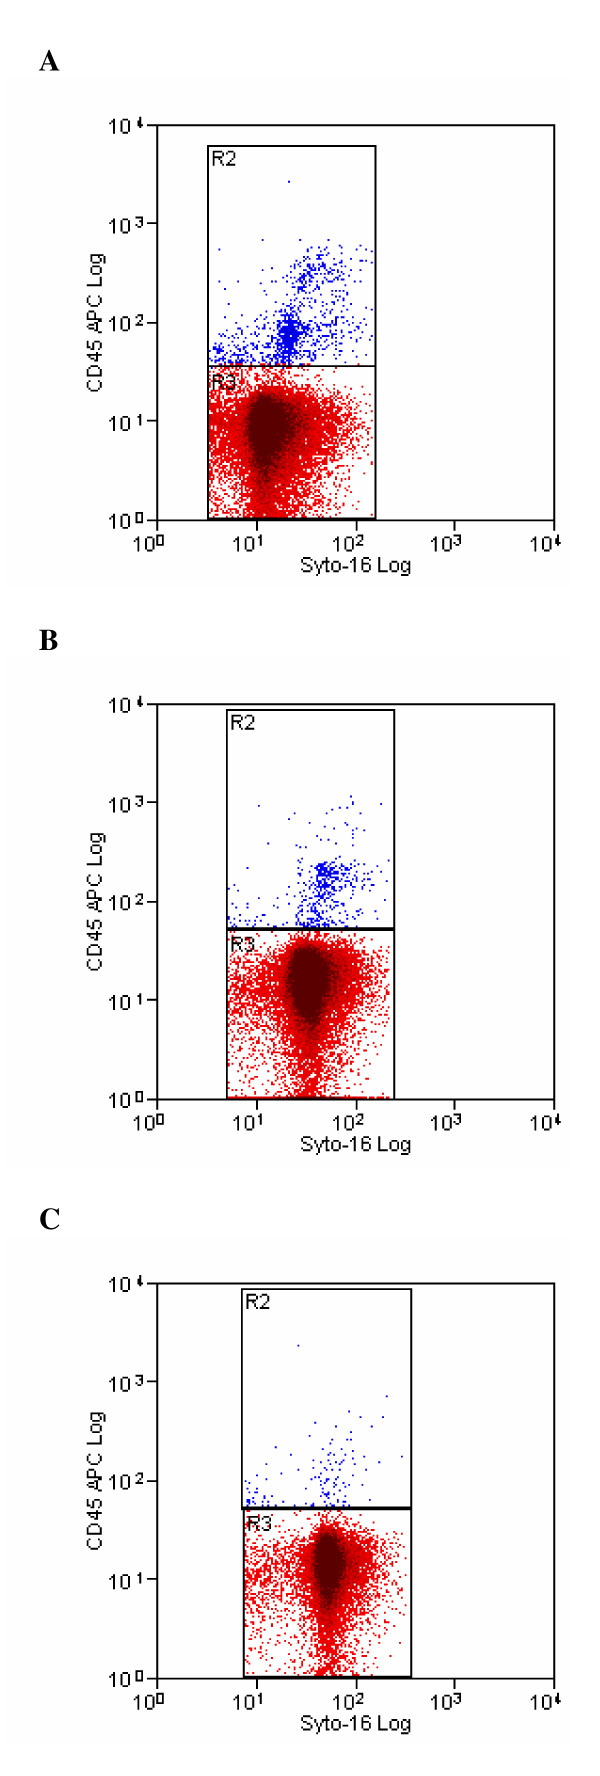
Pre- (3a) and post-processing (3b, 3c) cytofluorimetric analysis of a semen sample with a moderate leukocyte concentration. Cytogram 3a displays the cytofluorimetric analysis of a semen sample containing a moderate concentration of leukocytes moderate, stained with Syto-16 and CD45 to identify sperm and leukocytes. Region R2 (blue colour) and Region 3 (red colour) represent the number of leukocytes and sperm counted, respectively. Cytograms 3b and 3c displays the cytofluorimetric analysis of the same sample after density-gradient centrifugation and after swim-up technique, respectively.